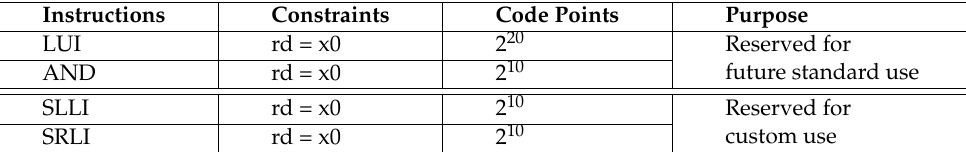
Table 1. Hint instruction table in RISC-V. The first column presents the base instruction. The second shows the constraints’ conditions. The third shows the number of possible expressions with programmable bits in each instruction. The last presents the purpose of the hint